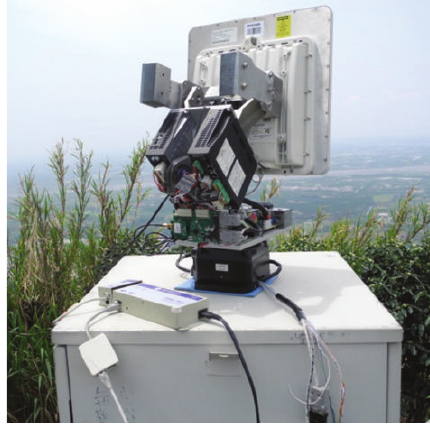
Figure 13: Ground antenna tracking mechanism with microwave module.